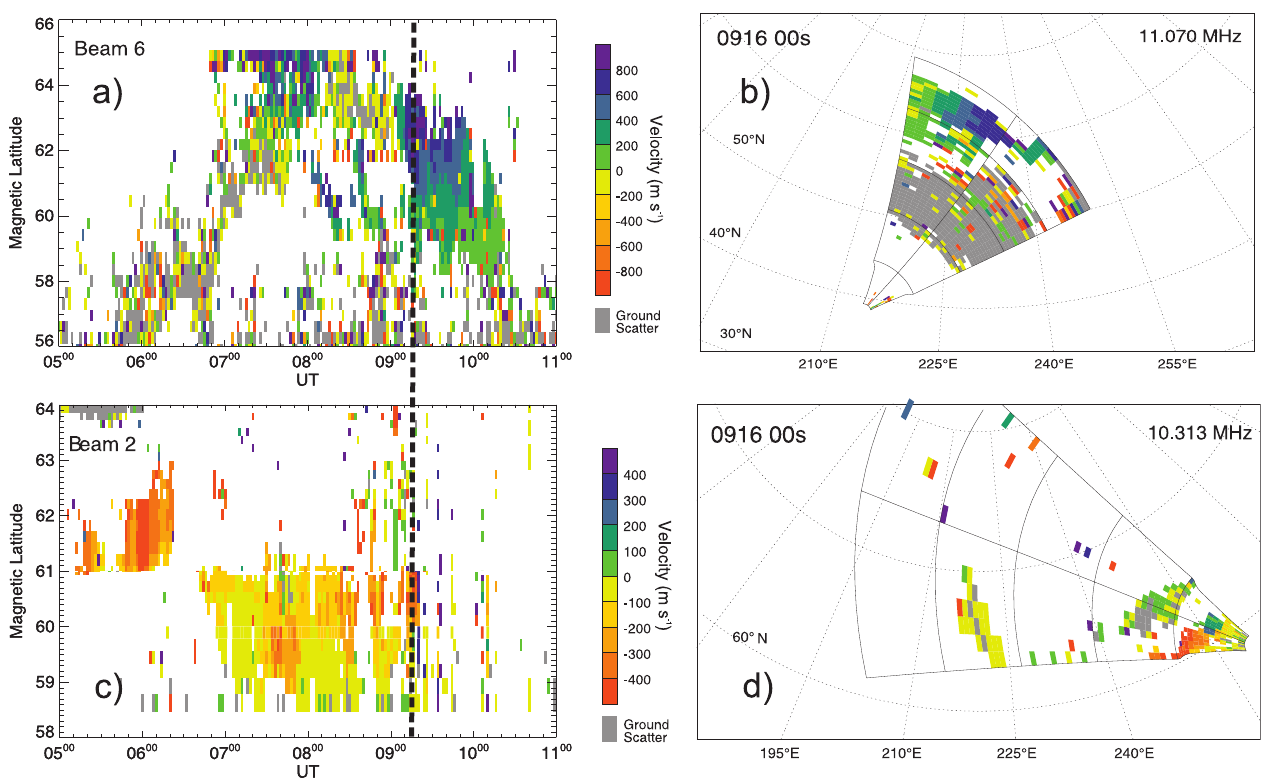
Fig. 3. (a) Echo velocity in beam 6 of the Hokkaido radar for 1 April 2007 between 05:00 and 11:00UT. (b) Velocity map for the period of the fast flow detection (dashed line in panel a). (c) and (d) are the corresponding KSR radar data in the same